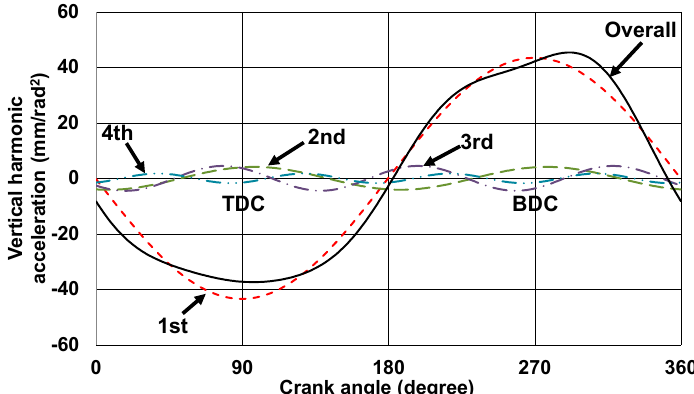
Figure 4. Vertical harmonic acceleration components at piston pin ( P 6 ) of the initially designed Stephenson III mechanism in a single cylinder.